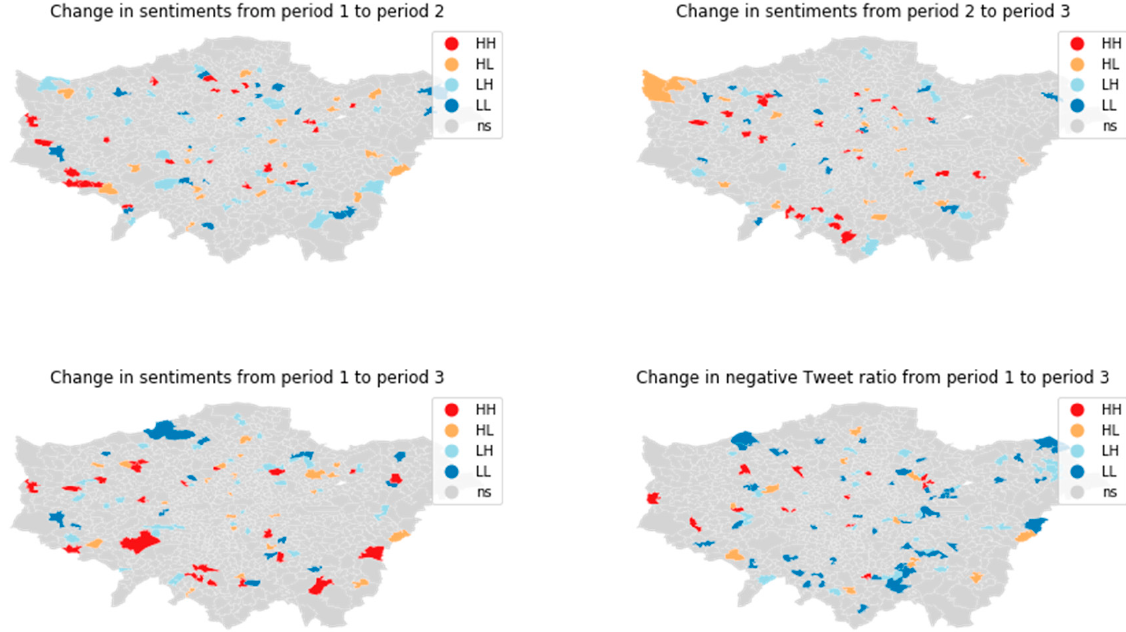
Figure 5. Comparison of spatial clusters (local Moran’s I, p < 0.05) of changes in sentiment scores over time for MSOAs .